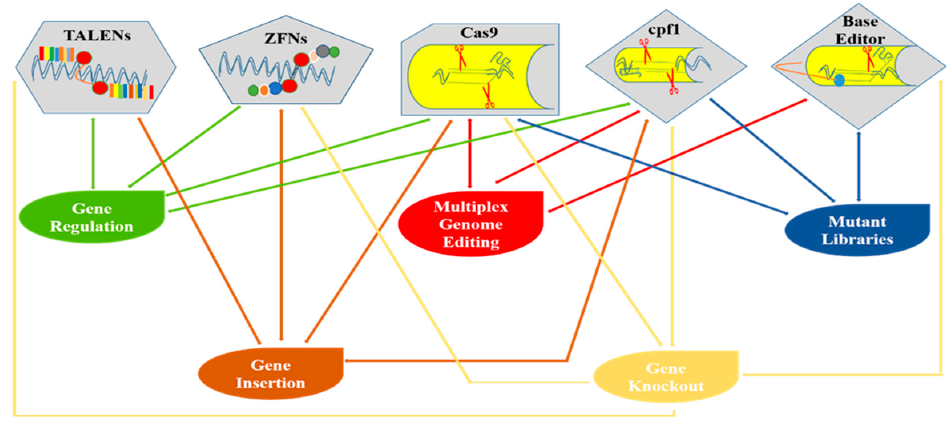
Figure 2. Diagrammatical representation of various genome editing tools and their applications in plants.